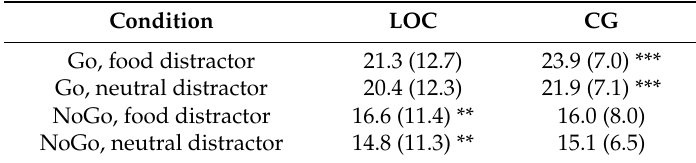
Means and SDs (in parentheses) for P300 amplitudes by group and condition. Asterisks mark significant differences between food and neutral distractor, separately for group and Go vs. NoGo stimulus. ** marks significant differences ≤ 0.01; *** marks significant differences ≤